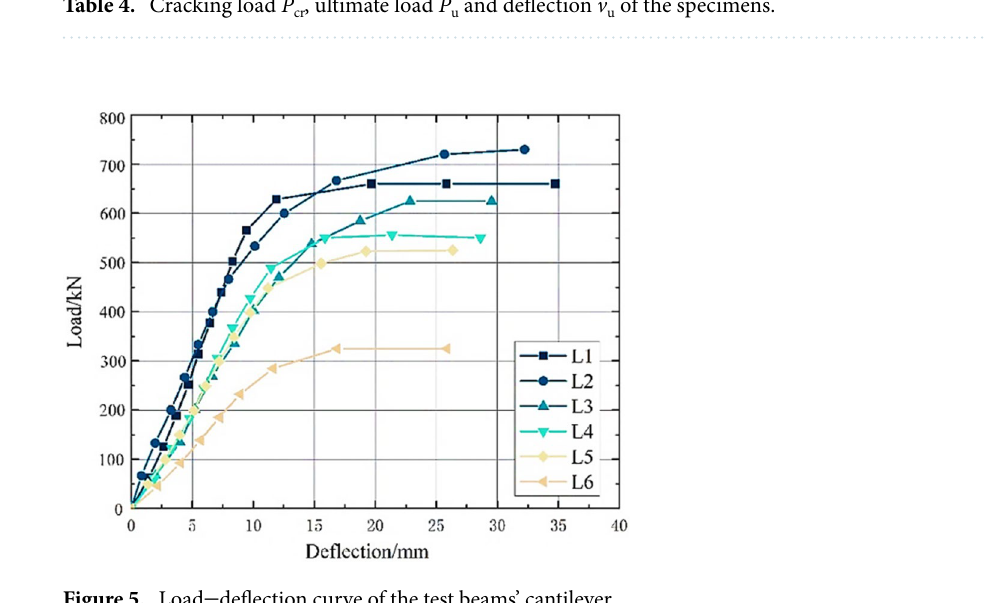
Figure 5. Load ‒ deflection curve of the test beams’